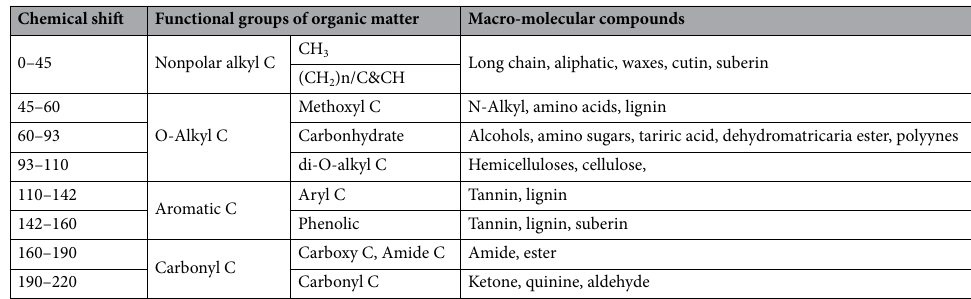
Table 3. 13 C solid-state NMR determination of organic carbon functional groups and corresponding high- molecular-weight